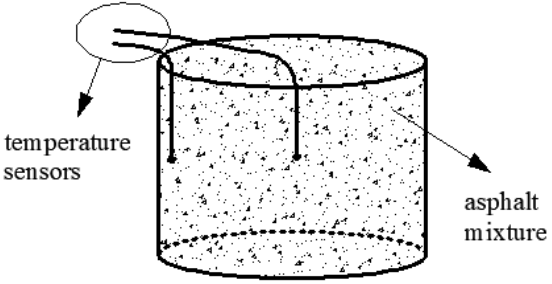
Figure 4. Layout of the temperature sensors.